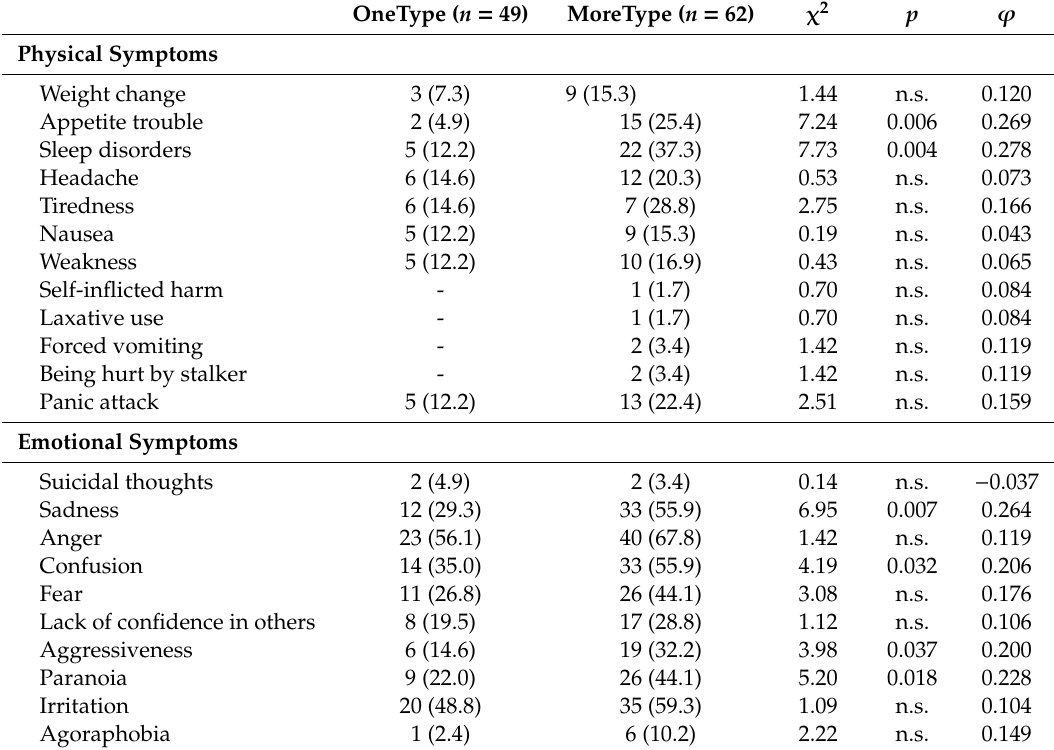
Table 1. Physical and emotional symptoms: comparison between OneType and MoreType (percentage in brackets) victims. χ 2 = chi-square value; n.s. = not statistically significant: ϕ = phi